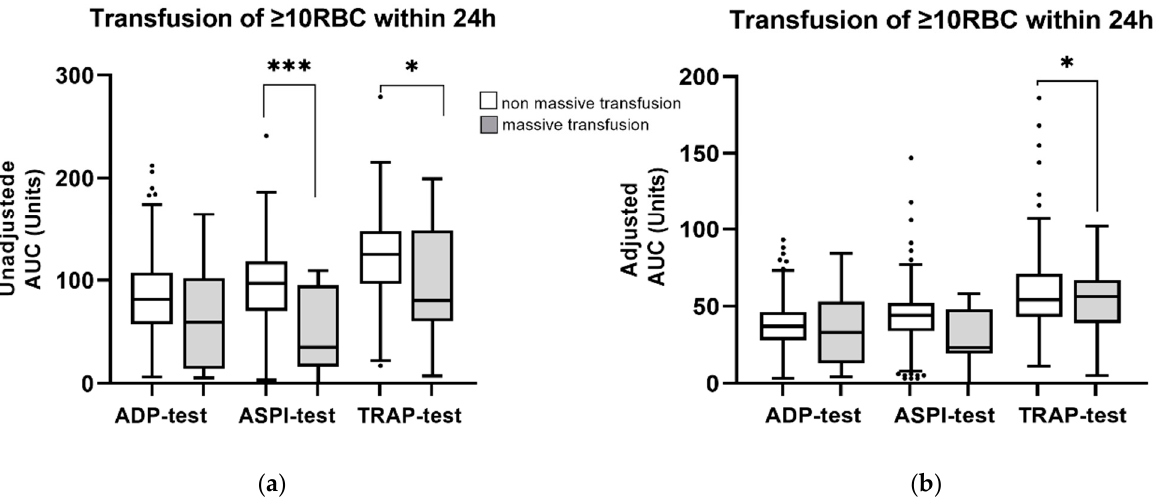
Figure 3. ( a , b ) Multiplate tests and analyses for transfusion of ≥ 10RBCs within 24 h after hospital admission, unadjusted and adjusted for platelet count. White square, non-massive transfusion; grey square, massive transfusion; ADP, adenosine diphosphate; ASPI, arachidonic acid test; TRAP, thrombin-receptor-activating peptide. AUC, area under curve; RBC, red blood cell; * p <0.05; *** p <0.001; no indication = not significant. Data are presented as box and whisker plots (Tukey). Student’s t -test or Mann–Whitney rank sum test was used as appropriate for between-group comparisons.